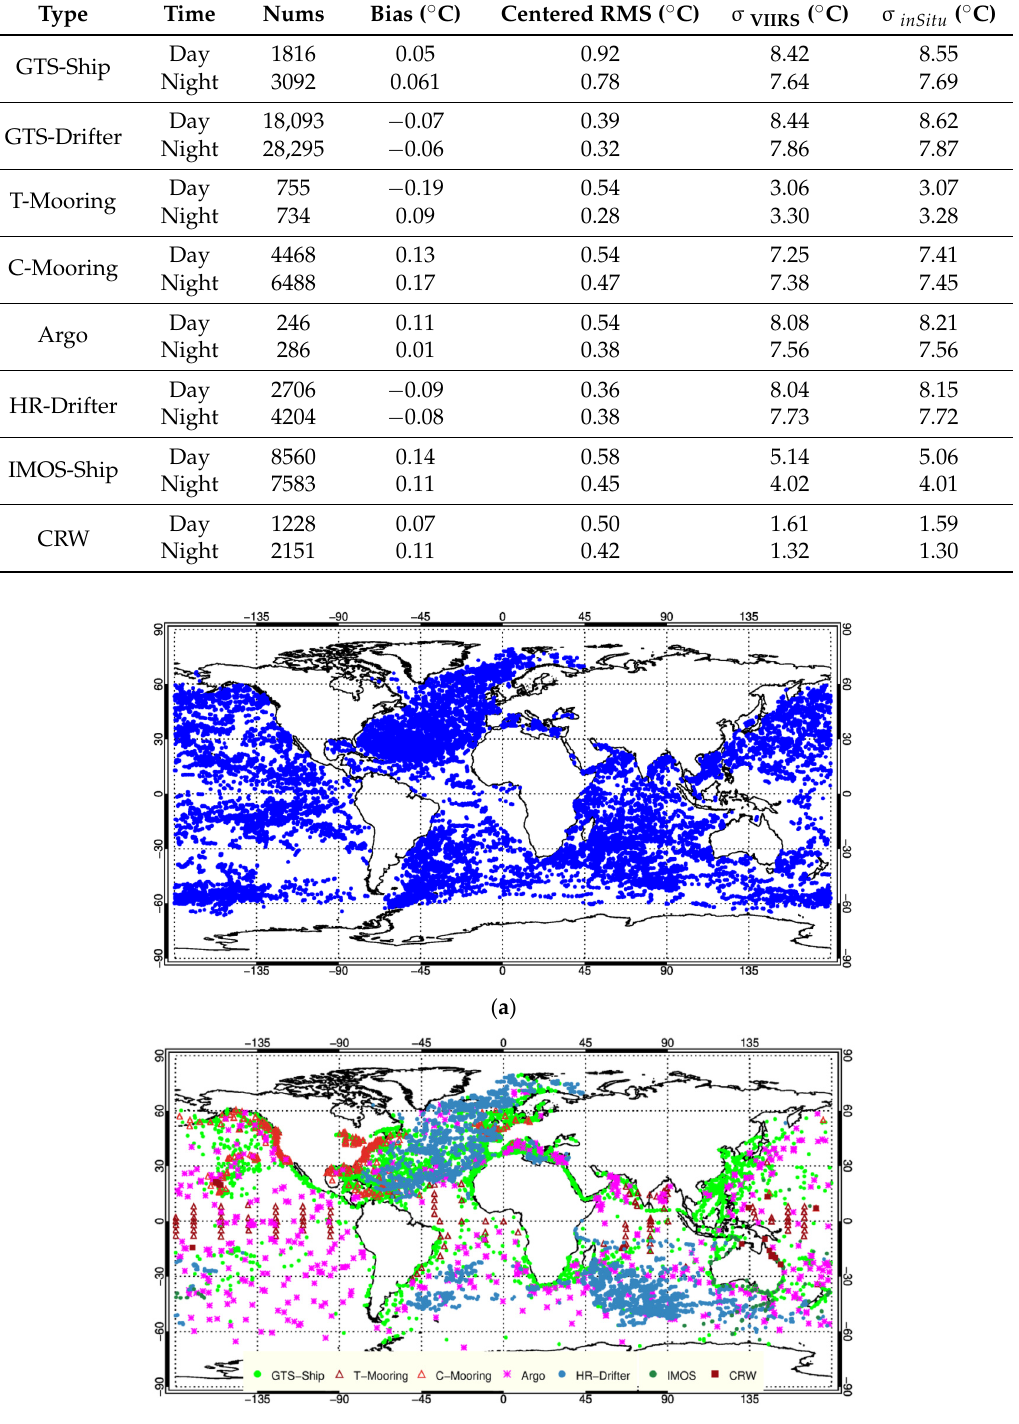
Table 2. Supplementary statistical information corresponds to Figure 2.